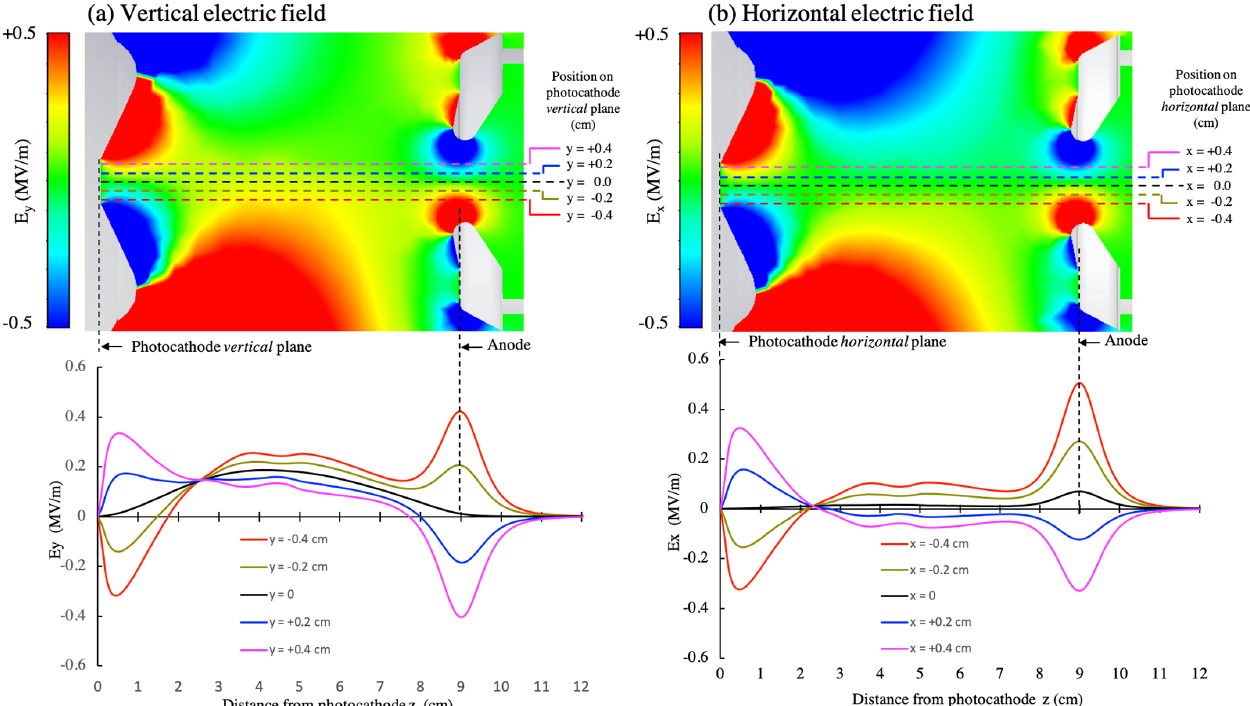
FIG. 8. Color map of the photogun anode-cathode gap at − 300 kV showing the transverse electric field Ey within the anode-cathode gap, in a vertical plane centered on the anode-cathode axis (a). The bottom plot shows the magnitude of Ey plotted along the dotted lines shown in the field map. The position of each dotted line is indicated with respect to the axis, and (b) corresponding plots for